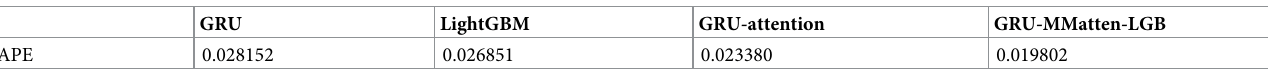
Table 5. MAPE of all methods without noise.